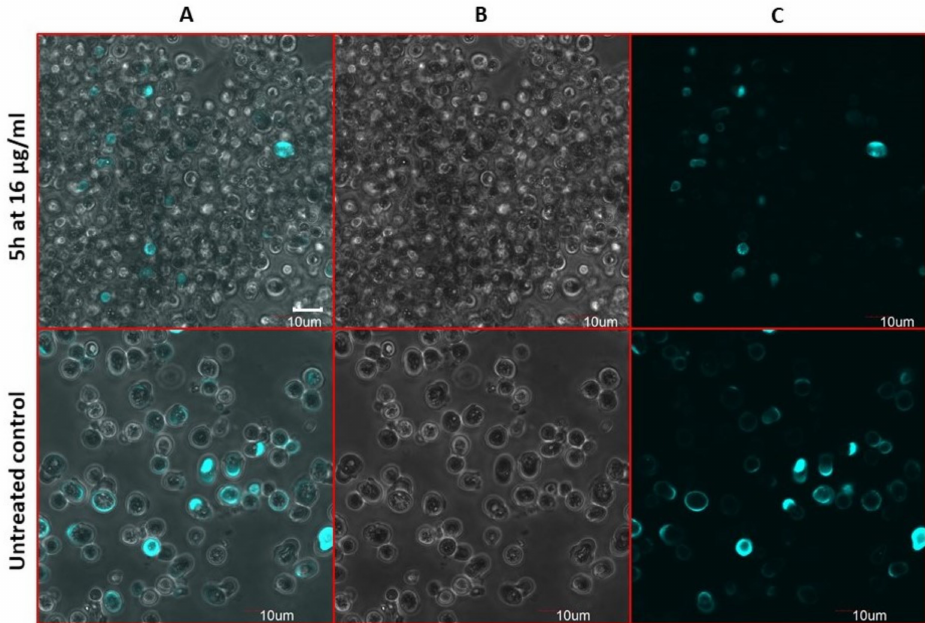
Figure 6. The fluorescent staining of the C. neoformans SPZ173 biofilm with calcofluor white (CFW). Legend: Confocal laser scanning microscope (CLSM) analyses: ( A ) phase contrast and fluorescence merged; ( B ) phase contrast and ( C ) fluorescence images. ( A – C ) Upper raw depicts sessile cells treated with 5h at 16 µ g/mL. Sessile cells-treated with 5h showed weak CFW staining. Lower raw included the untreated controls showing several cells with bright blue fluorescence.